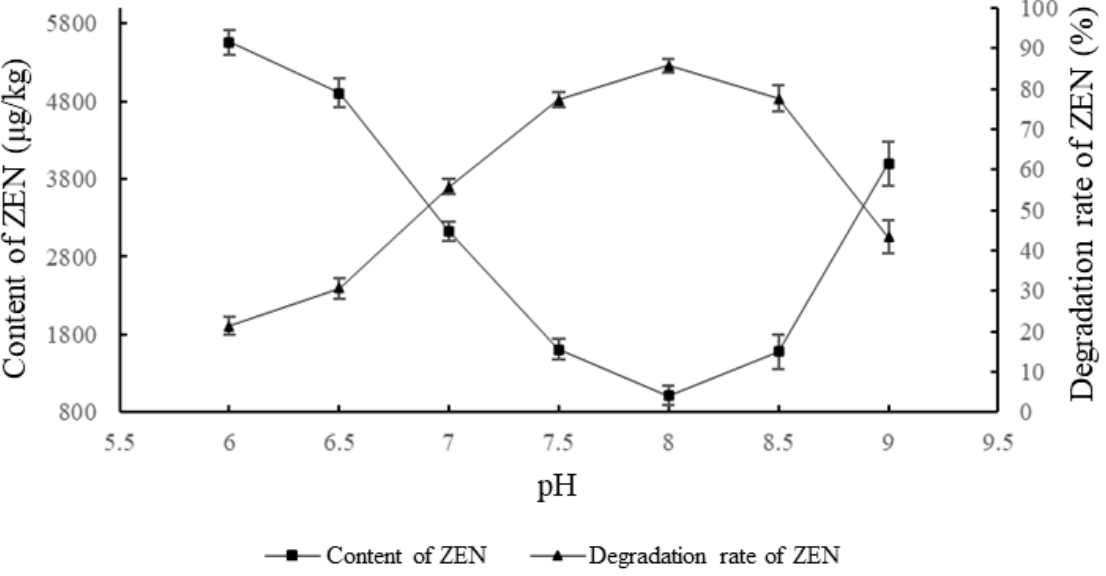
Figure 2. Effects of reaction pH on the degradation of zearalenone.